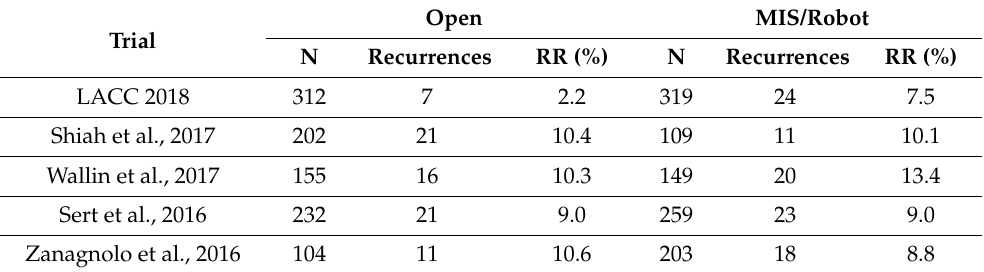
Table 1. Comparison of recurrence rates (RR) in different surgical trials of cervical cancer [21–23].